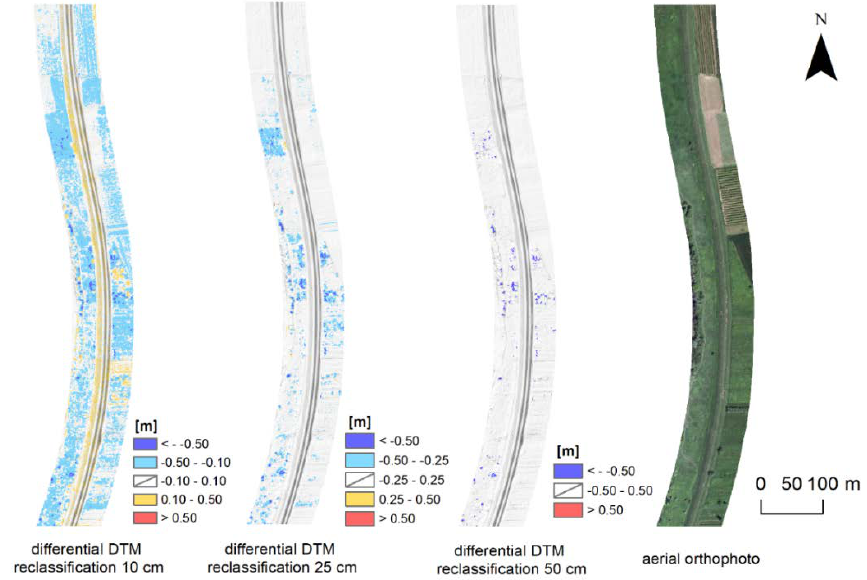
Figure 4. Results of differential DTM reclassification using distinct threshold values (0.10 m, 0.25 m and 0.50 m) and an orthophoto (2015) of the test area.